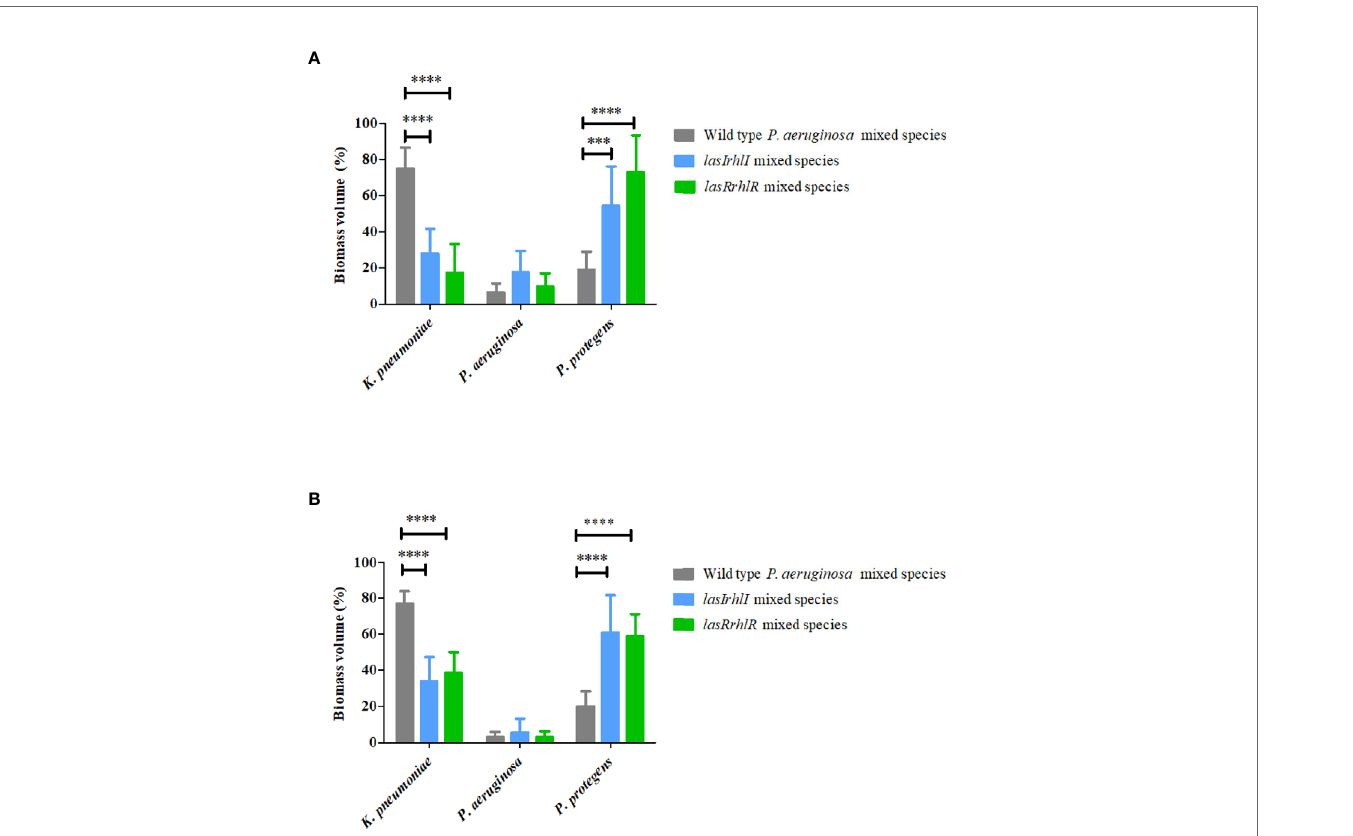
FIGURE 1 | Proportions of the mixed species bio fi lm. The proportions of the three species in the mixed species bio fi lm containing either the P. aeruginosa wild type or the QS mutants ( lasIrhlI or lasrRrhlR ) after (A) 3 days and (B) 5 days of cultivation. Bar charts depict the percentages of K . pneumoniae , P. aeruginosa , and P. protegens in the wild type or QS mutant mixed species bio fi lm. The proportions were derived by cultivating bio fi lms under fl ow cell conditions followed by quantitative image analysis of two independent biological replicates. Error bars represent standard deviations (n = 2). *** and **** denote signi fi cant difference by two-way ANOVA followed by Tukey ’ s post-test ( P < 0.001 and P <